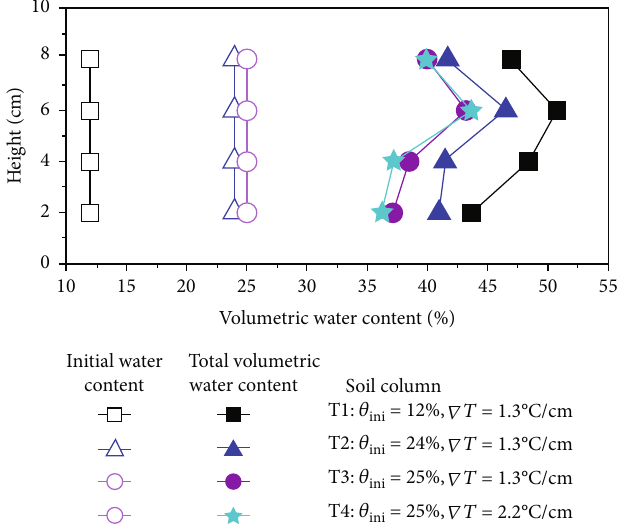
Figure 7: The volumetric water content changes of the soil columns before and after